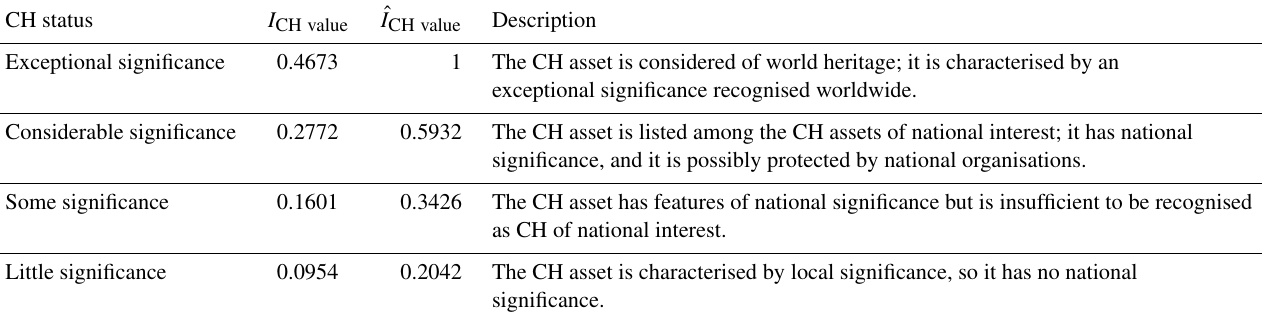
Table 7. CH significance scores.